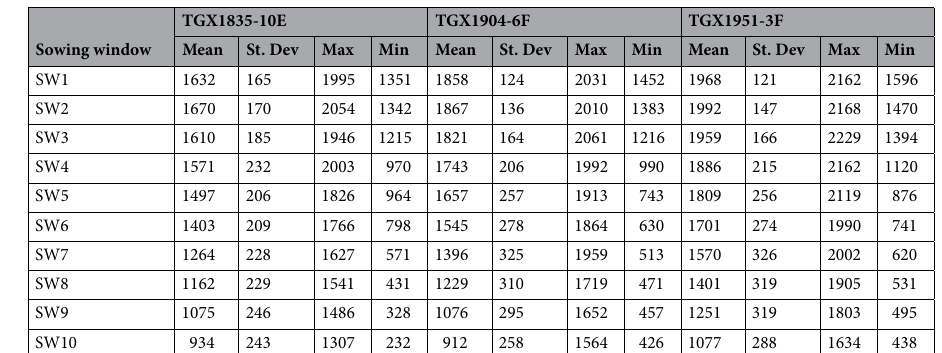
Table 6. Simulated grain yield (kg ha −1 ) of different sowing windows based on 30 ‐ year (1985–2014) seasonal analysis for soybean varieties (TGX1835 ‐ 10E, TGX1904-6F and TGX1951 ‐ 3F) in Zaria (northern Guinea savanna). SW1: June 1–7; SW2: June 8–14; SW3: June 15–June 21; SW4: June 22–28 June; SW5: June 29–July 5; SW6: July 6–July 12; SW7: July 13–July 19; SW8: July 20–July 26; SW9: July 27–August 2; SW10: August 3– August 9.